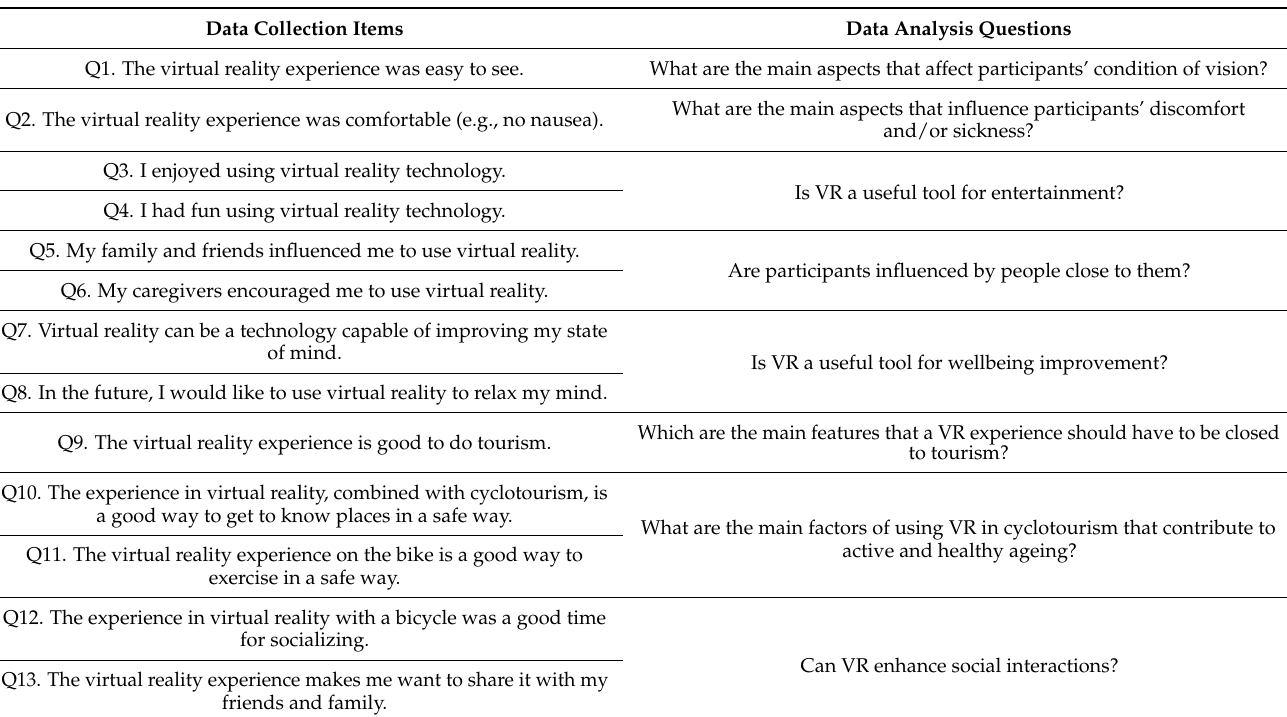
Table 2. Overview of the items from the questionnaire and correspondent questions for data